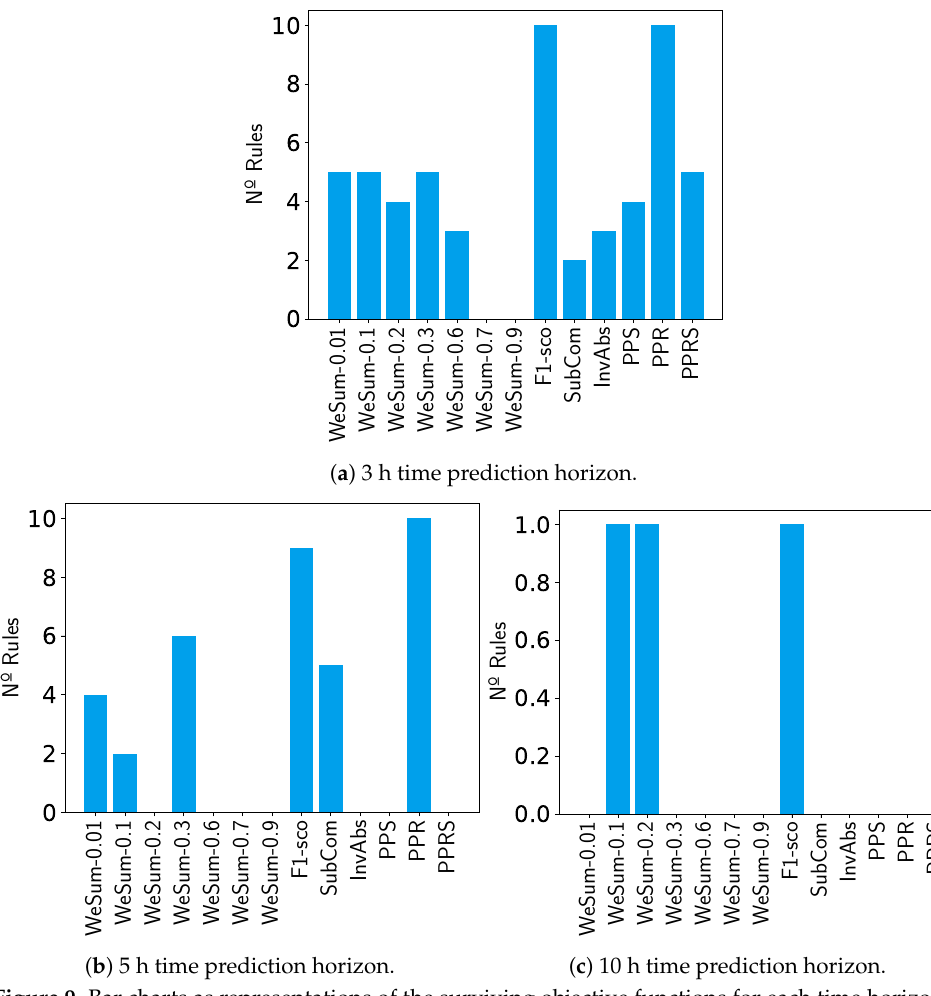
( b ) 5 h time prediction horizon. Figure 9. Bar charts as representations of the surviving objective functions for each time